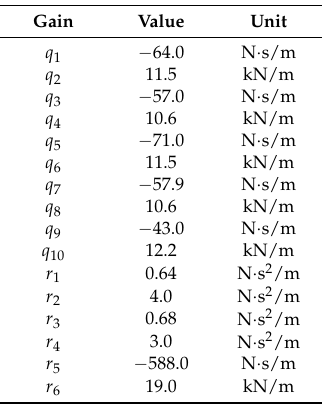
Table 5. Optimum gains of active seat suspension controller